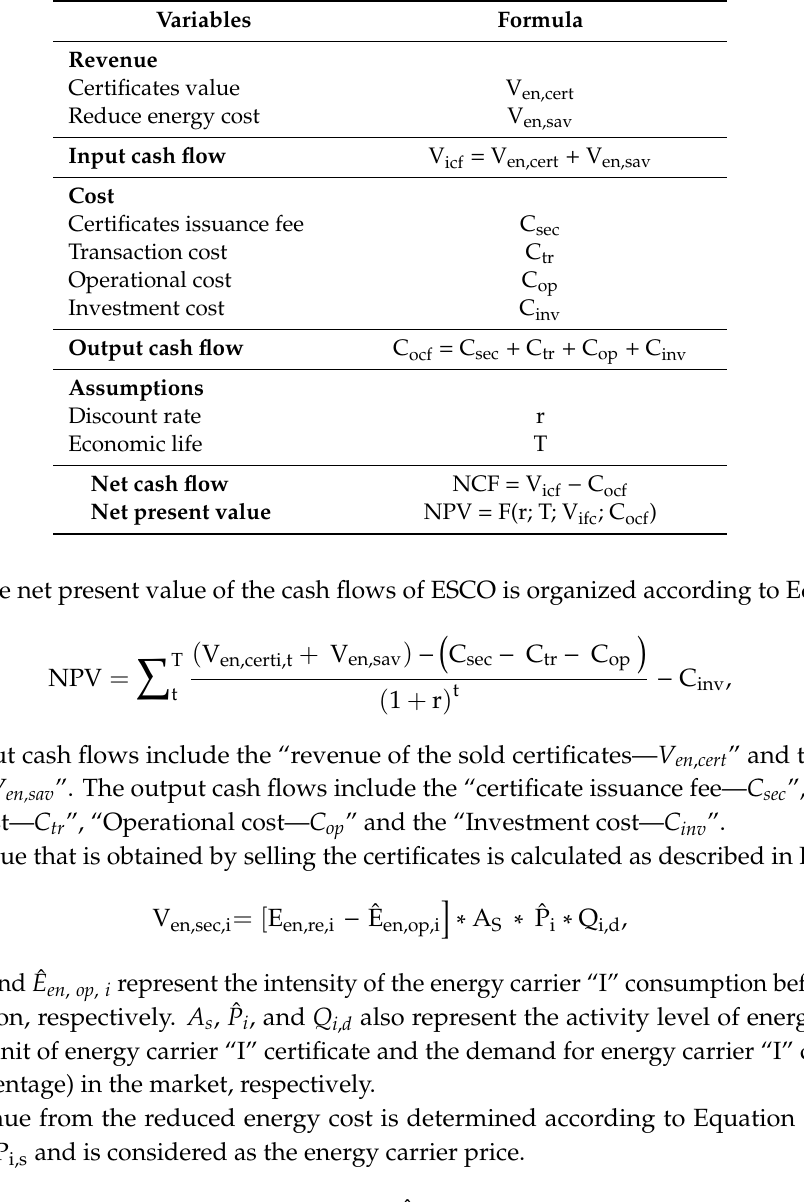
Table 2. The variables and assumptions in the Net Present Value (NPV)